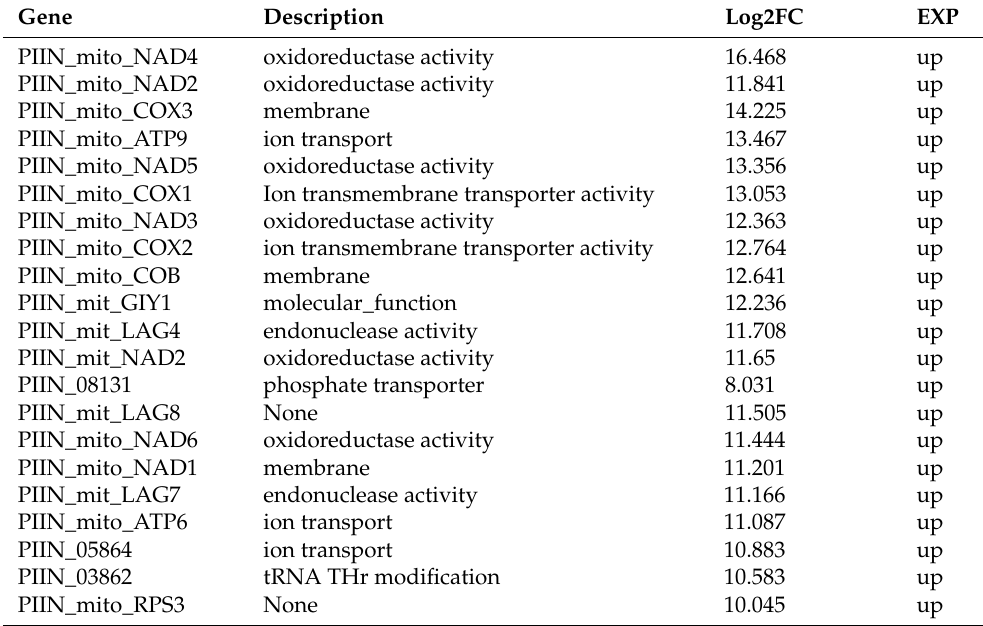
Table 1. Top 20 P. indica differentially expressed genes (DEGs) during colonization (3 dai vs. control).